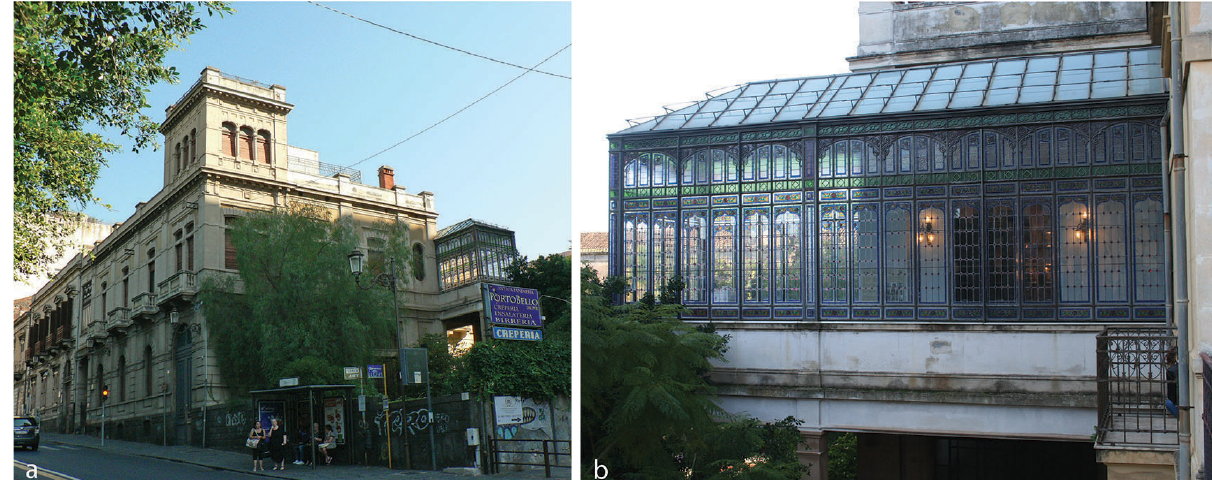
Figure 2. Views of villa Zingali Tetto : a) exterior; b) winter garden made by Salvatore Gregorietti (Palermo 1870 - Palermo 1952)